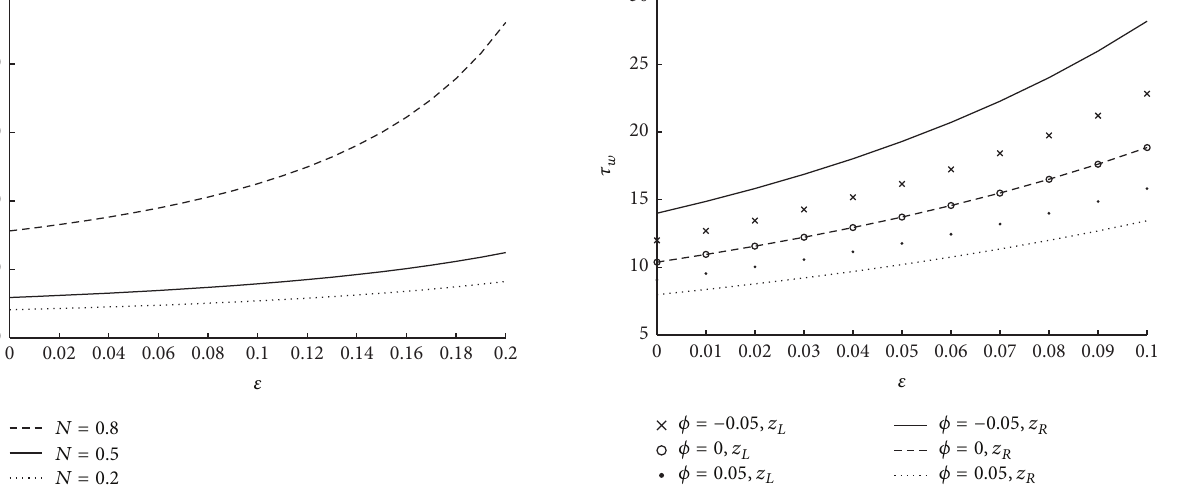
Figure 6: The variation of impedance with respect to 𝑁 when 𝑟 𝑐 = 0.1 , 𝑚 = 50 , Γ = 0.5 , 𝑢 = 0.01 , and 𝜙 = −0.05 .